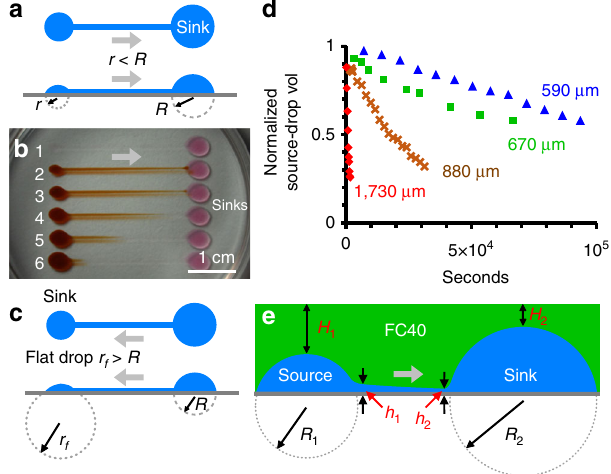
Fig. 2 Using Laplace pressure to drive fl ow through FF circuits. Grey arrows : direction of fl ow. a Principles. In this simple circuit (plan, side views ), the left ‐ hand drop has the smaller radius of curvature ( r < R ), and a pressure difference between the drops is the main driver of fl ow. b A frame from Supplementary Movie 3. Media (20 µ l) was added through the 5 ml overlay of FC40 to each sink drop; next, 10, 8, 6, 4, and 2 µ l red dye were pipetted successively into drops 6 – 2, and the dish photographed after ∼ 30